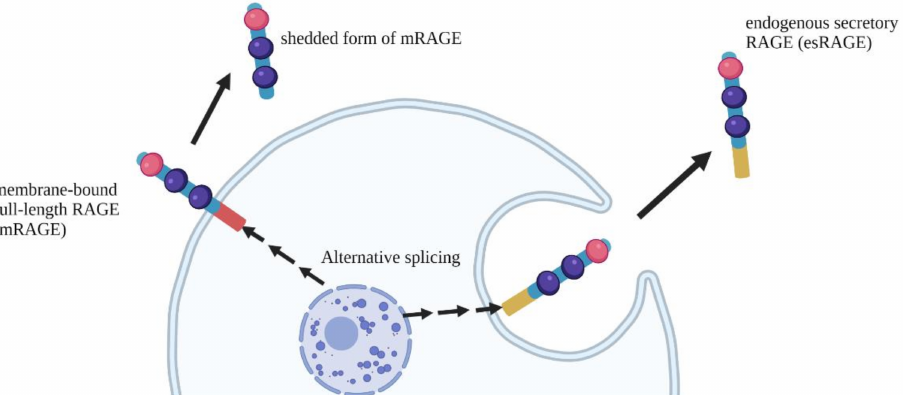
Figure 1. Schematic diagram of RAGE variants. Membrane-bound full-length RAGE (mRAGE) is the signal transduction form expressed on the cell surfaces. The soluble forms of RAGE (sRAGE) include endogenous secretory RAGE (esRAGE), a product of an alternatively spliced mRNA, and an ectodomain-shed form of